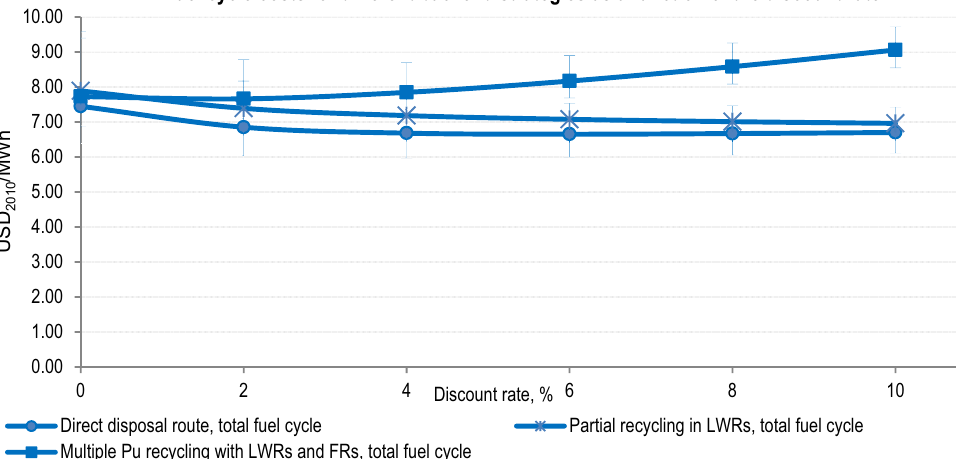
Fig. 3. Fuel cycle costs for different back-end strategies as a function of the discount rate for a fl eet generating 400